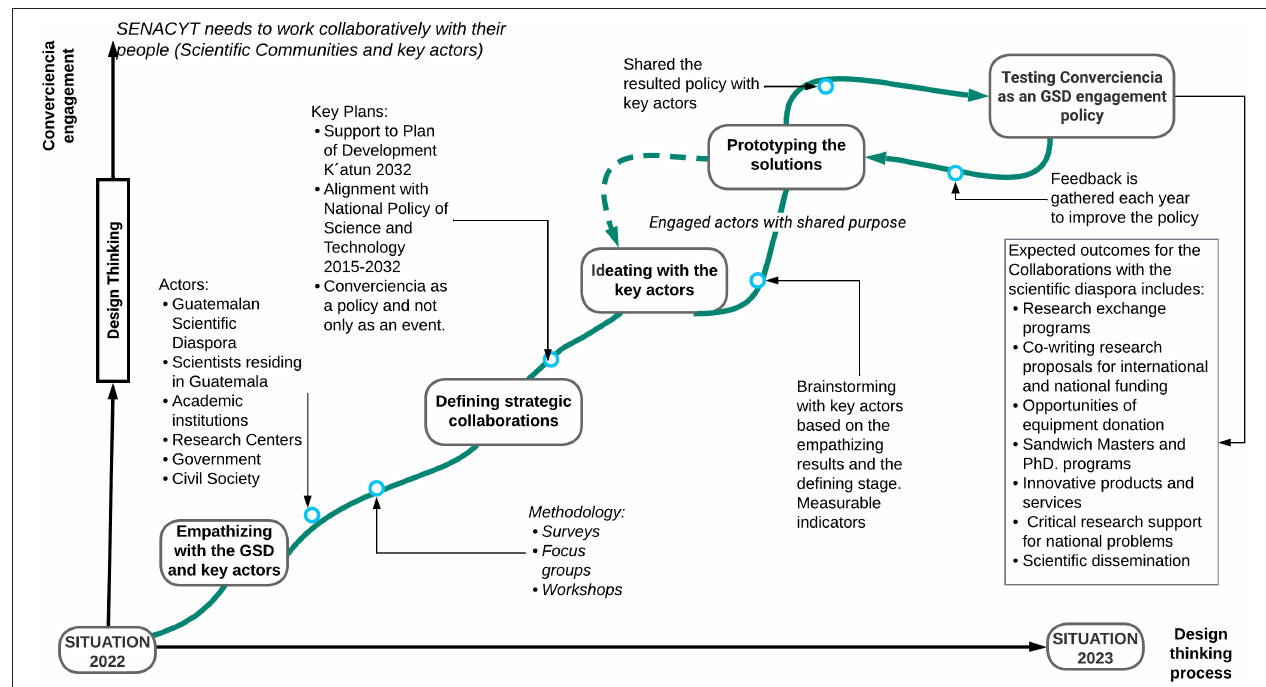
FIGURE 6 | Converciencia as a policy to engage the Guatemala scientific diaspora (GSD). Source: own